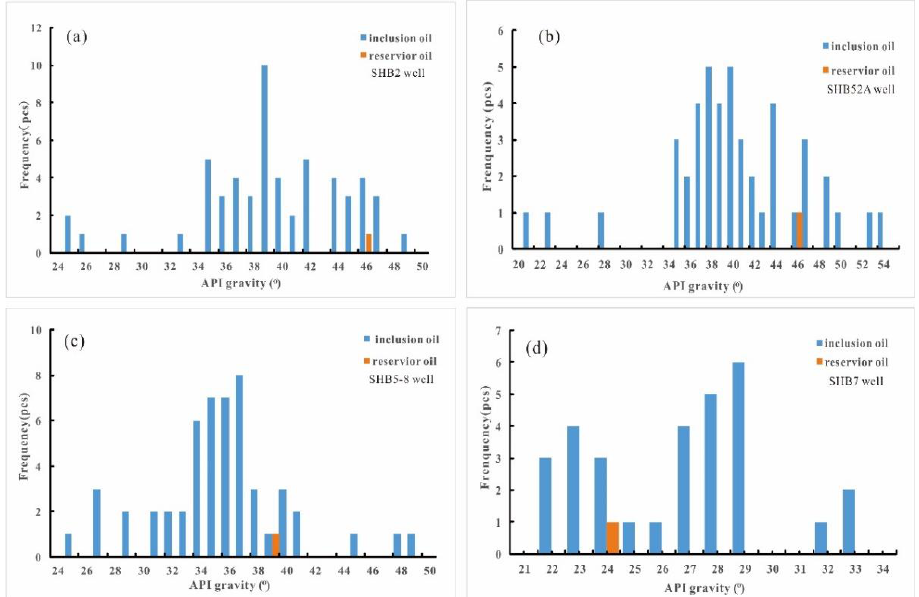
Figure 11. Histogram of the API° frequency distribution for oil inclusions from the Shunbei area. (a) SHB2 well, (b) SHB52A well, (c) SHB5-8 well, (d) SHB7 well. ( a ) SHB2 well, ( b ) SHB52A well, ( c ) SHB5-8 well, ( d ) SHB7